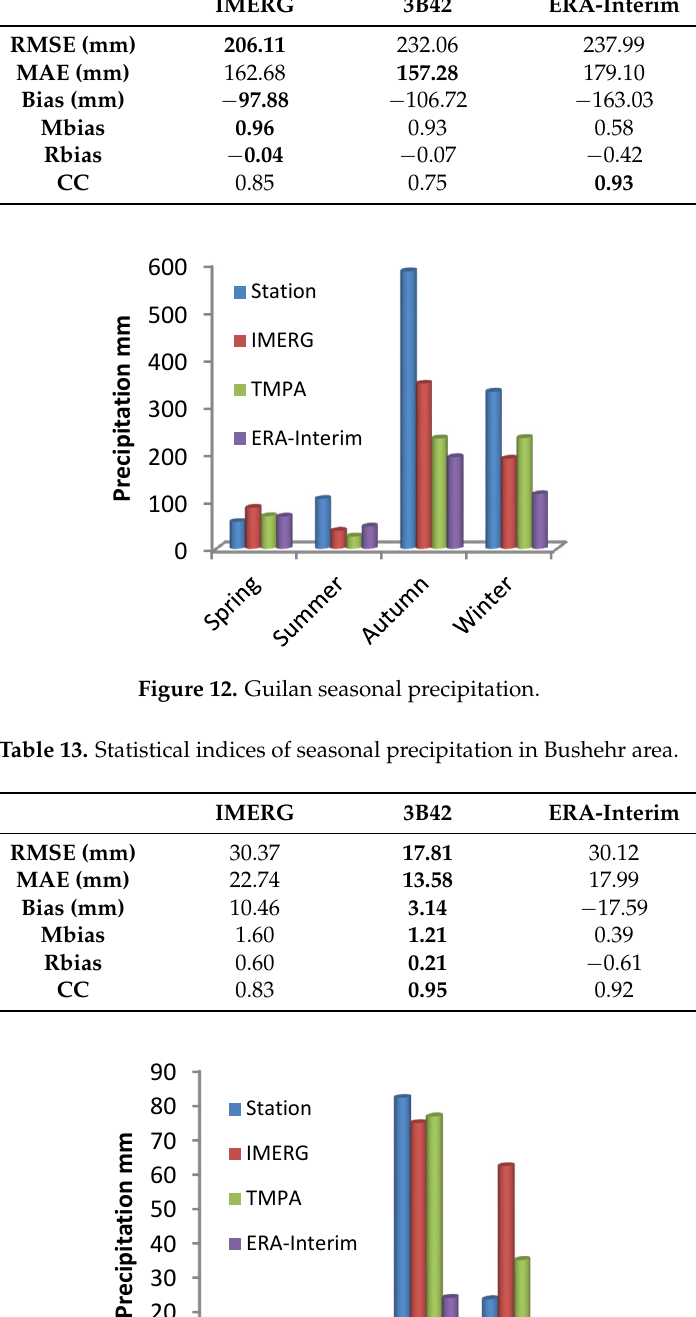
Table 14. Statistical indices of seasonal precipitation in Kermanshah area.